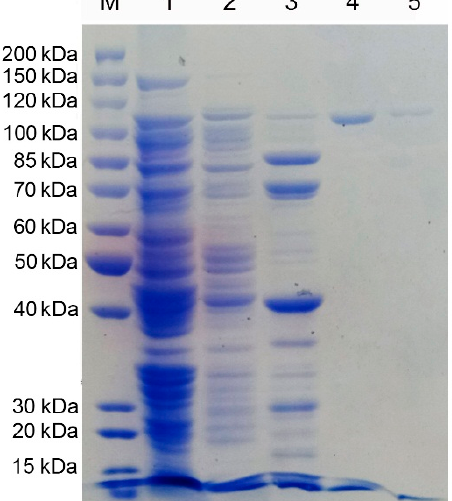
Figure 3. SDS-PAGE of purification of recombination YsHyl8A: M, Protein Marker; 1, Breakthrough peak; 2, 25 mM imidazole elution; 3, 100 mM imidazole elution; 4, 200 mM imidazole elution; 5, 300 mM imidazole elution.